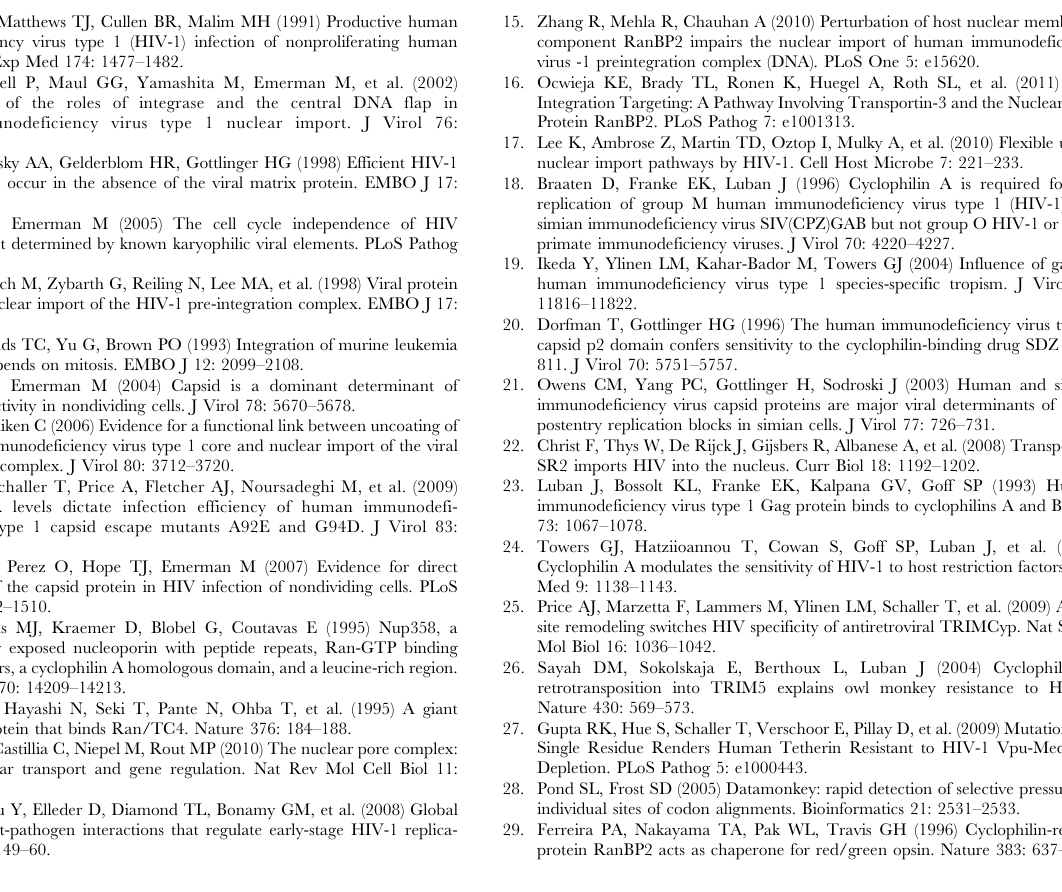
Figure S8 Effect of CypA inhibition on Nup358 or transportin3 RNAi sensitivity. HeLa cells expressing scram- bled control (SC), Nup358 or transportin 3 (TRN-SR2) specific shRNA were infected with a fixed dose of wild type or mutant HIV-1 GFP in the presence of increasing concentrations of Cs (0– 10 m M). Percentage infection was measured 48 hours later by detecting GFP positive cells using flow cytometry and plotted against Cs concentration. Figure S9 Effects of TRN-SR2 or Nup358 RNAi on HIV-1 Env pseudotyped vectors. HeLa cells stably expressing scrambled control (SC), Nup358 or transportin 3 (TRN-SR2) specific shRNA were transduced with MLV vector MiGRI-CD4- IRES-neo and drug selected with G418. Similar CD4 expression was determined by antiCD4 APC staining (Figure S4). Generated cells were infected with HIV-1 GFP vectors that were pseudotyped with HIV-1 Env derived from YU-2. Infectivity of wild type HIV- 1 (WT) was reduced similarly strongly as compared to VSV-G pseudotyped virus. HIV-1 CA mutants P90A and N74D showed a slightly increased sensitivity to both TRN-SR2 as well as Nup358 RNAi, suggesting envelope specific effects as suggested in a previous study for TRN-SR2 [31]. Table S1 Effects of aphidicolin treatment. Shown are fold reductions of infectious titers from graphs in Figure 3A. Left site